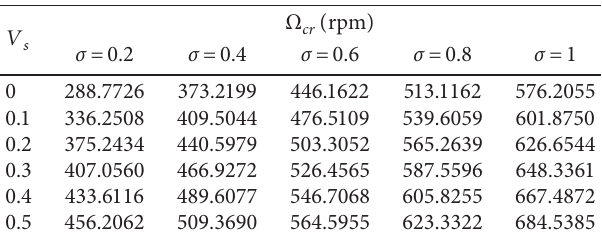
Table 3: The critical rotating speed corresponding to the different SMA wires fractions and taper ratio for C-C boundary condition